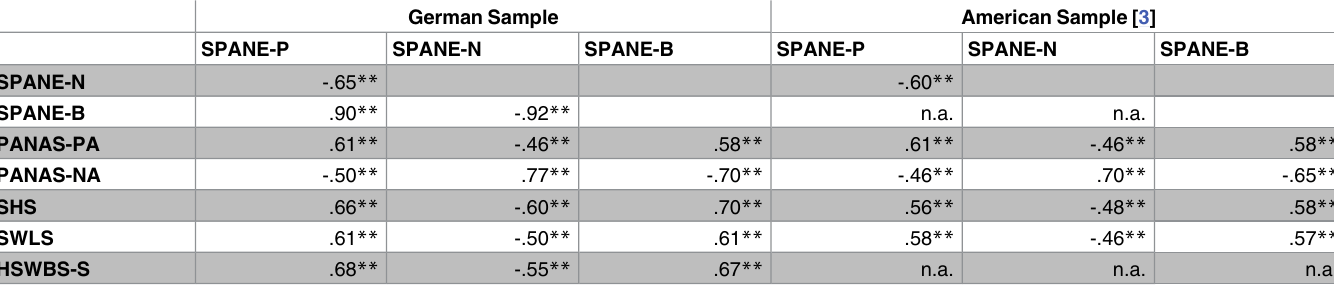
Table 5. Construct validity: Convergence with other relevant